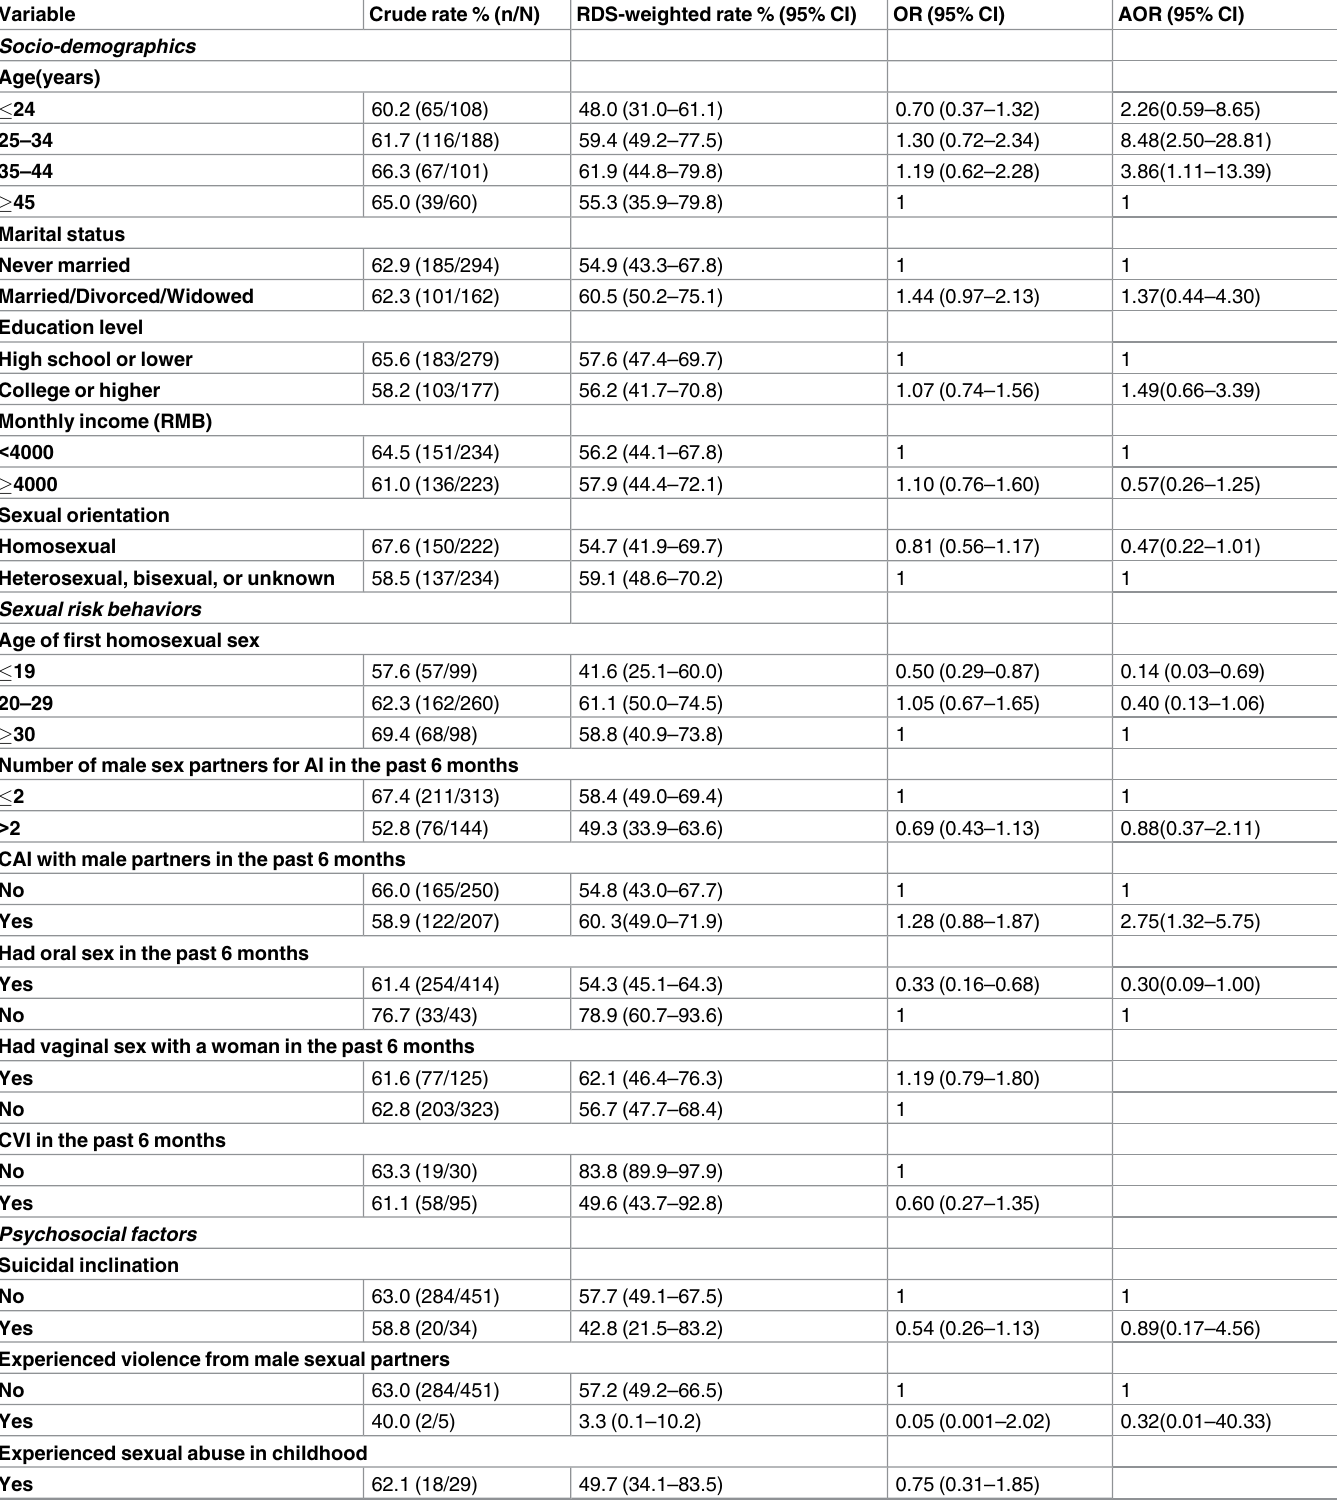
Table 3. Factors associated with recent HIV testing among MSM (N =